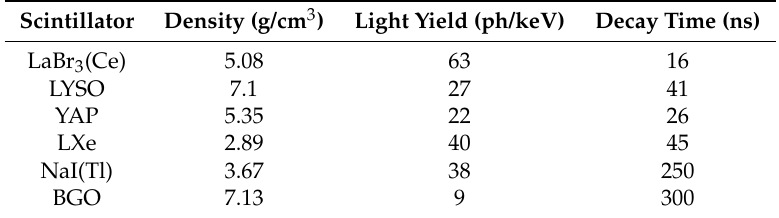
Table 1. Properties of state-of-the-art scintillators relevant for the application on µ + → e + γ